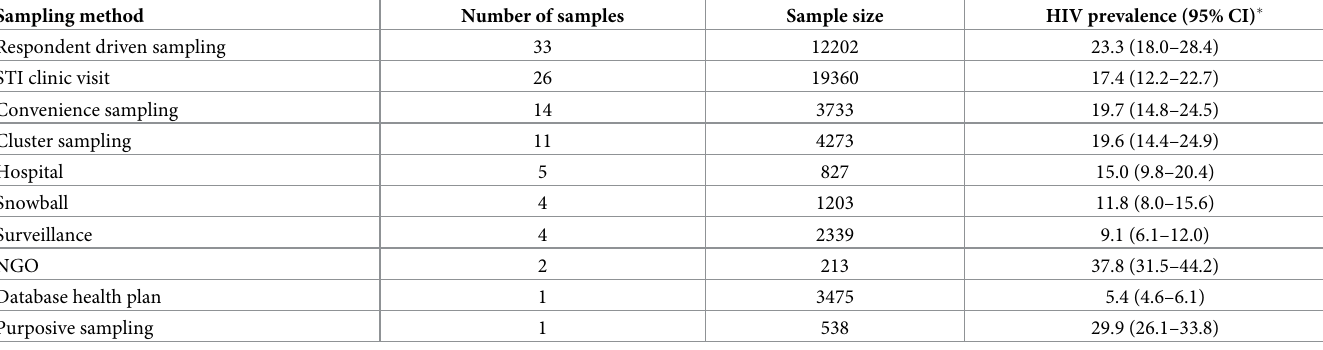
Table 5. HIV prevalence in trans feminine individuals, separated by sampling method.